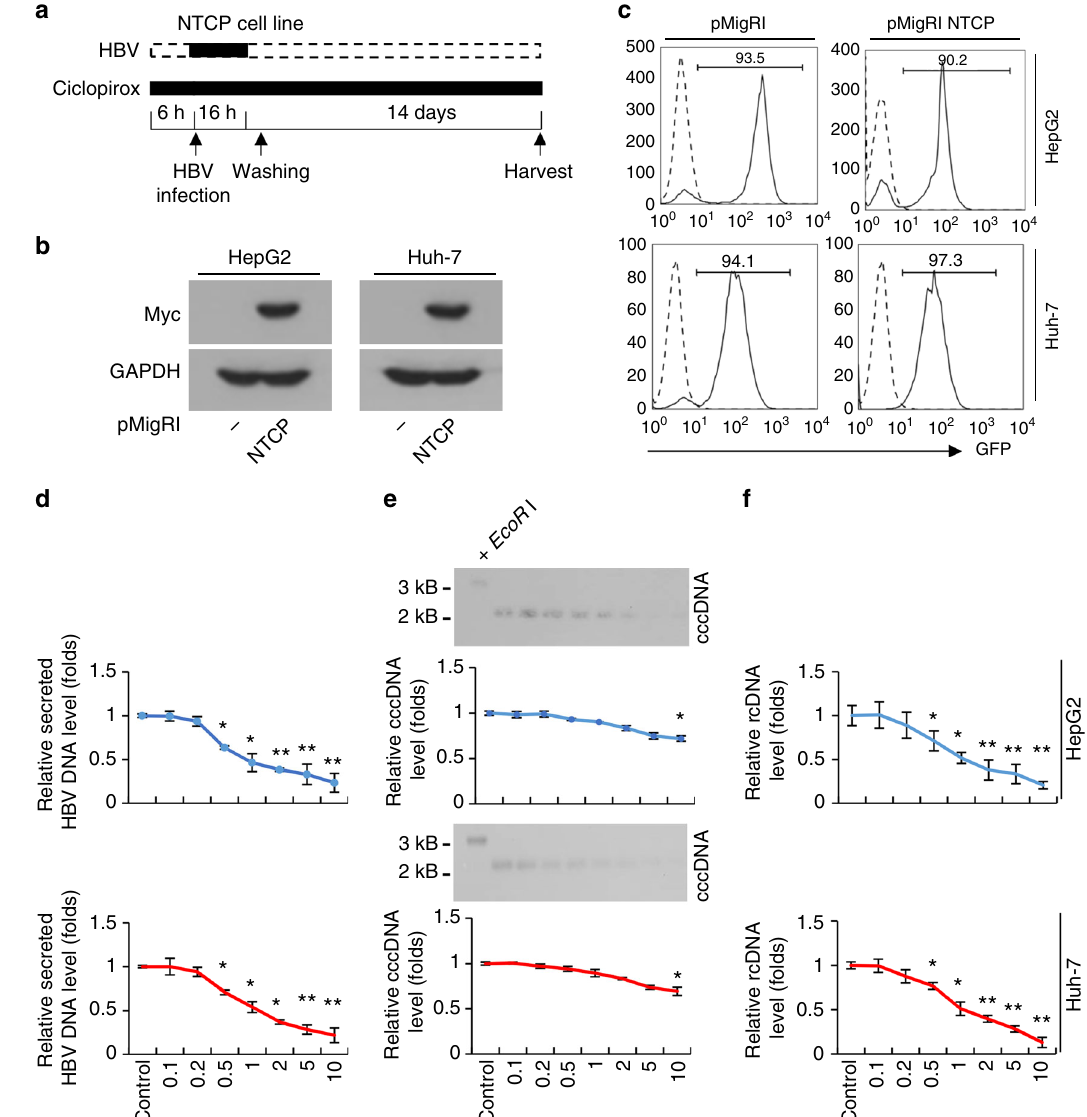
Fig. 5 Ciclopirox inhibits HBV replication in an in vitro HBV infection model. a Schematic depiction of the experiment. HepG2-NTCP and Huh-7-NTCP cells were treated with ciclopirox for 6 h and exposed to HBV for 16 h. After washing, the cells were treated daily with ciclopirox and cultured for another 14 days. b NTCP protein expression analyzed by immunoblot analysis. c GFP protein expression analyzed by fl ow cytometry. d – f Quantitative PCR with an HBV DNA primer and probe set was used to measure secreted HBV DNA ( d ), intracellular cccDNA ( e ), and intracellular HBV rcDNA ( f ). Intracellular cccDNA was also detected by southern blot analysis ( e ). The data in b – f are representative of three independent experiments and are expressed as mean ± SD. The error bars represent the ± SD. * p < 0.05; ** p < 0.01, by unpaired two-tailed Student ’ s t -tests. Source data are provided as a Source Data fi